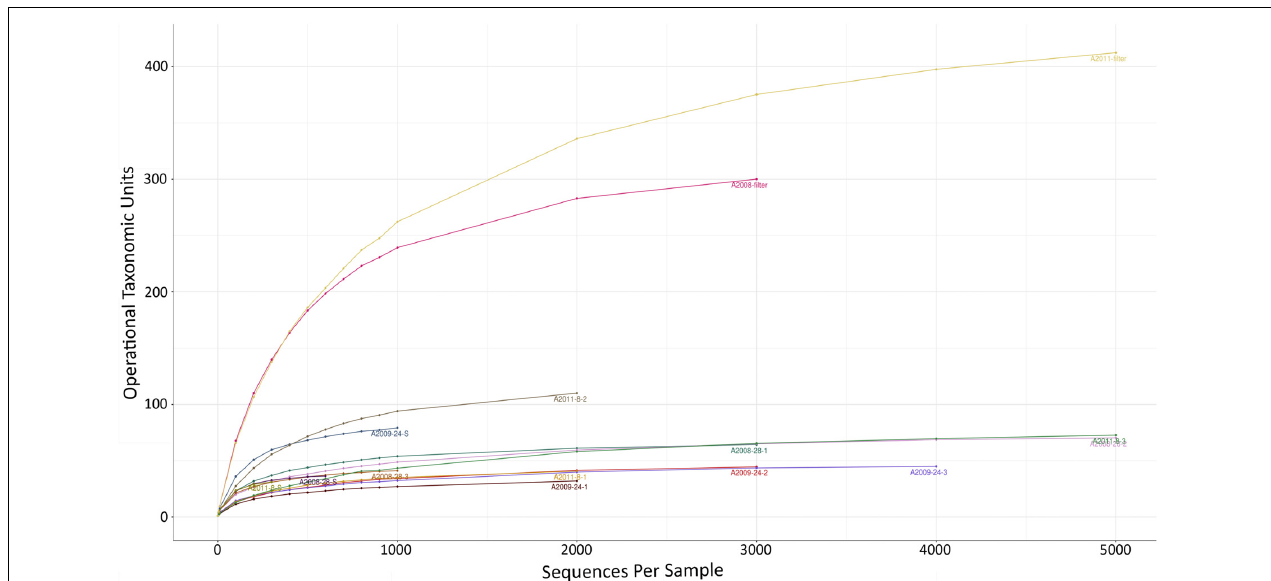
FIGURE 1 | Rarefaction curve showing the number of observed bacterial OTUs as a function of the number of sequences. Paragorgia arborea tissue and mucus samples ( n = 12) and seawater samples ( n = 2). Sample names as in Table 1 .